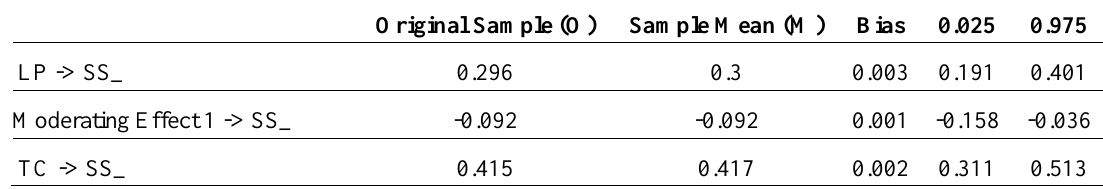
Table.6. Confidence Interval Bias